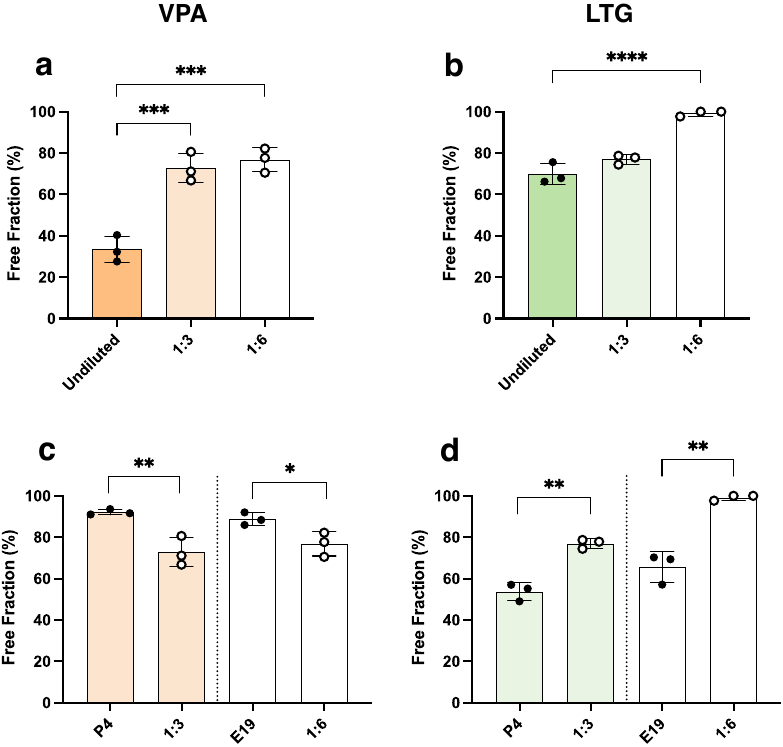
Figure 5. Free fraction of valproate and lamotrigine in diluted adult plasma. Protein-free fraction/whole plasma concentration ratios (%) of valproate ( a ) or lamotrigine ( c ) in undiluted adult plasma compared with adult plasma diluted 1:3 or 1:6 in phosphate buffered saline. ( b , d) . Comparison of free fraction of diluted adult plasma with P4 or E19 plasma of equivalent protein concentration. n = 3. Mean ± SD, n = 3. One-way ANOVA